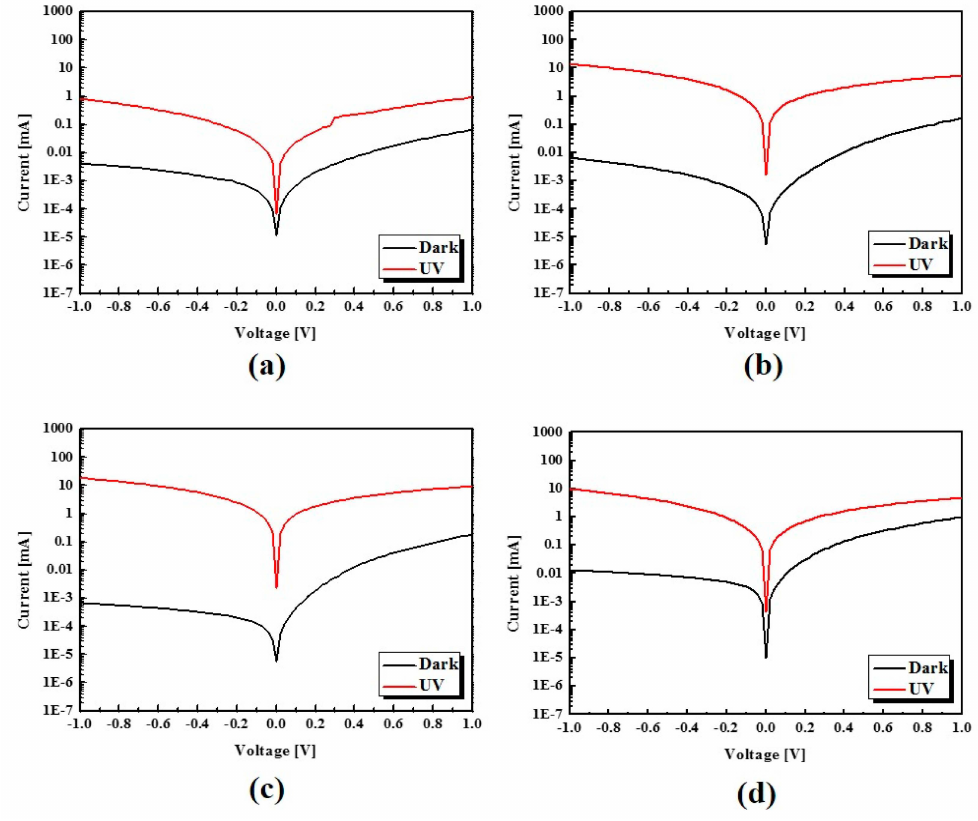
Figure 8. J-V characteristics of PVK/ZnO NPs hybrid UV photodetector under UV illumination of 1 mW/cm 2 : ( a ) UVPD 1; ( b ) UVPD 2; ( c ) UVPD 3; ( d ) UVPD